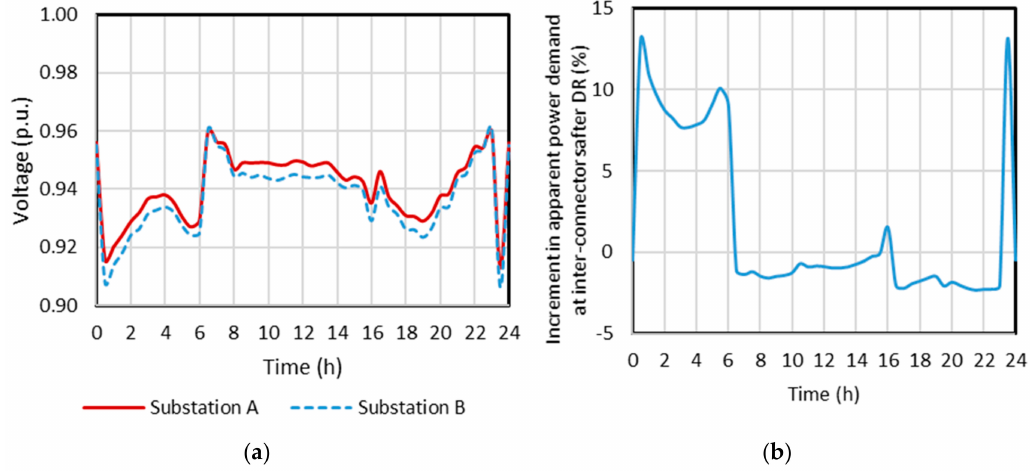
Figure 13. ( a ) Secondary voltage at transformers of both substations, and ( b ) increment in apparent power flow through inter-connectors after the implementation of DR for scenario